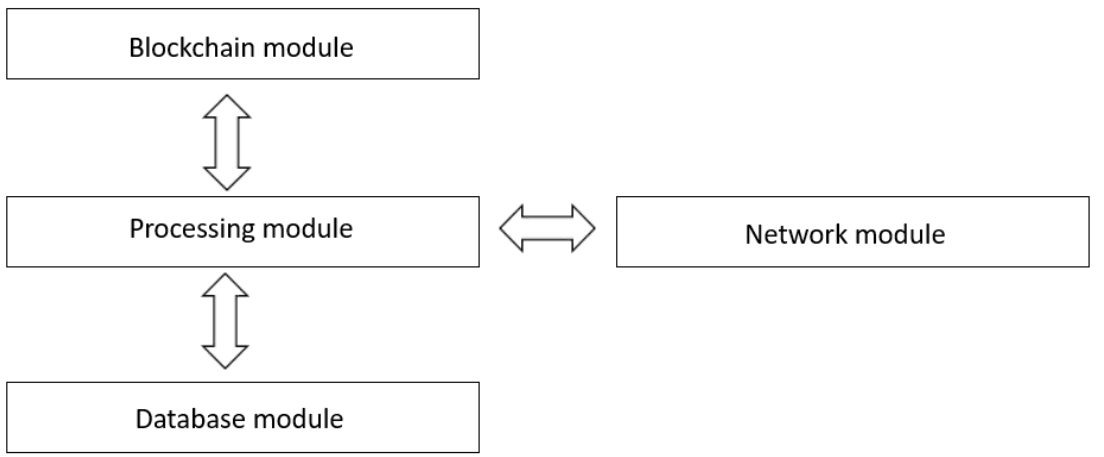
Figure 3. Server application system design.